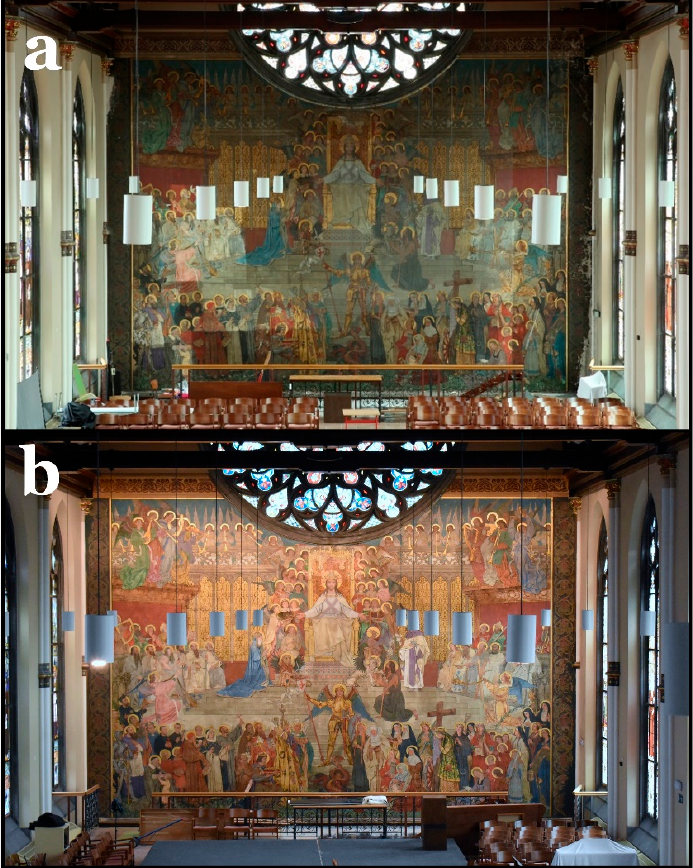
Figure 11. ( a ) The wall painting during the initial steps of conservation. ( b ) Final results of the wall painting after conservation and removal of the dark varnish layer.